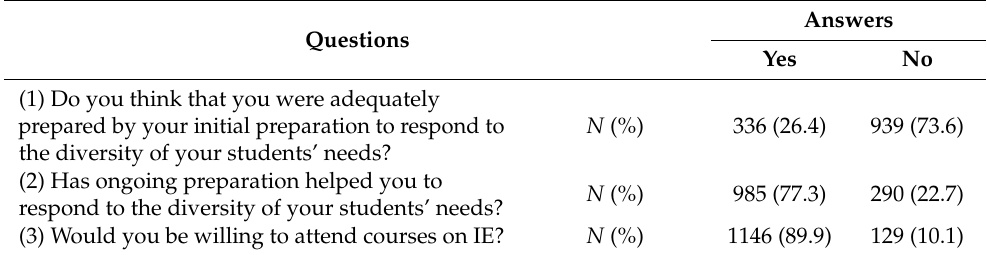
Table 3. Frequencies and percentages of teachers’ answers to the three dichotomous questions.